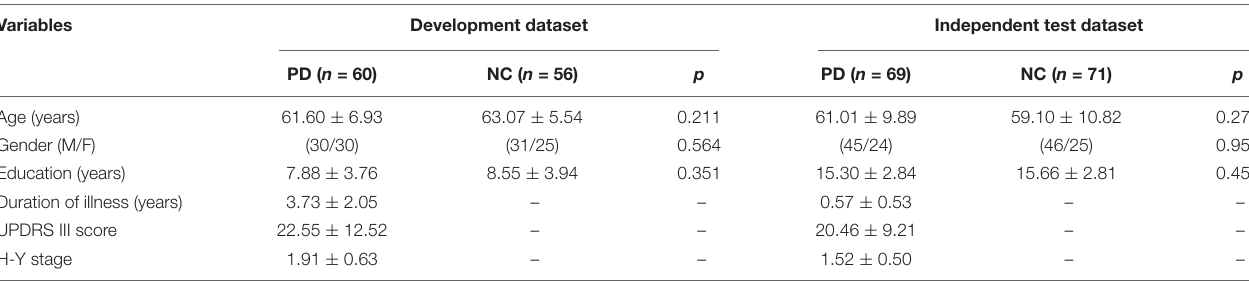
TABLE 1 | Demographic and clinical data of subjects in the development and independent test